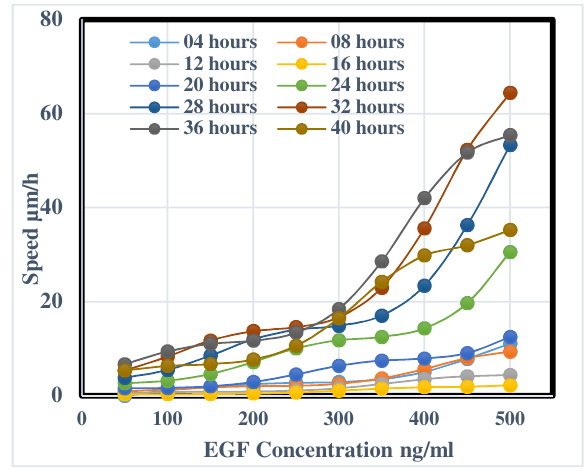
Fig. 12. Tangential speed of healing to the EGF concentration for 10 steps of